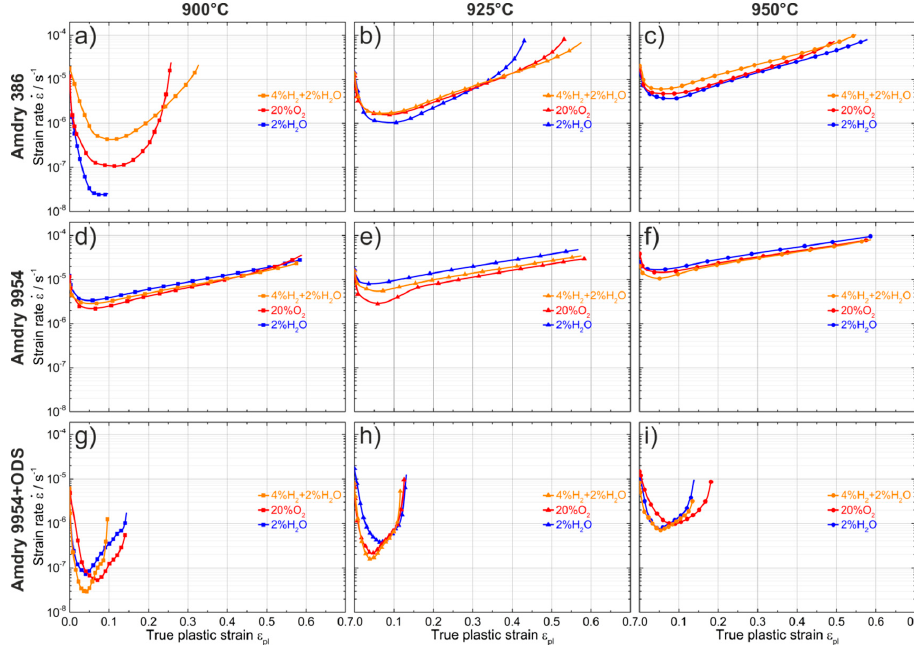
Figure 4. Strain rate versus true plastic strain plots at testing temperatures of 900–950 °C with an applied stress of 15 MPa. Before creep testing, Amdry 386 ( a – c ) Amdry 9954 ( d – f ) and Amdry 9954+ODS ( g – i ) were heat treated at 1100 °C for 72 h in Argon with the addition of 4% H 2 + 2% H 2 O, 20% O 2 and 2% H 2 O.